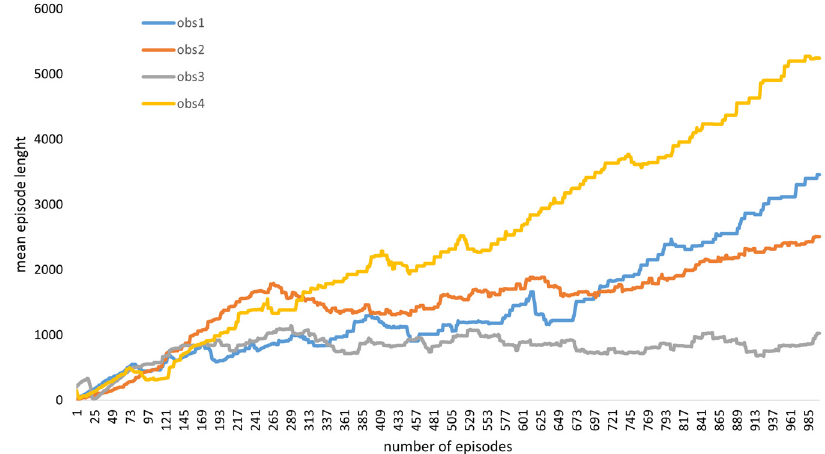
Figure 7. Training progress of the agent monitored by mean episode length for several observation spaces.